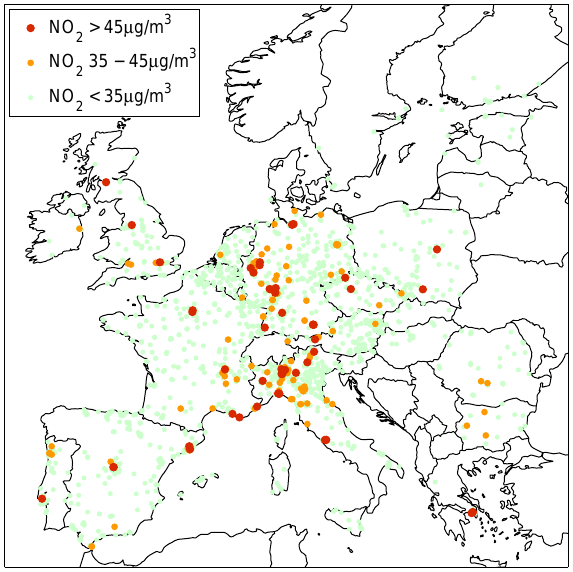
Fig. 12. Map of stations in different compliance categories as pro- jected for 2020 under current